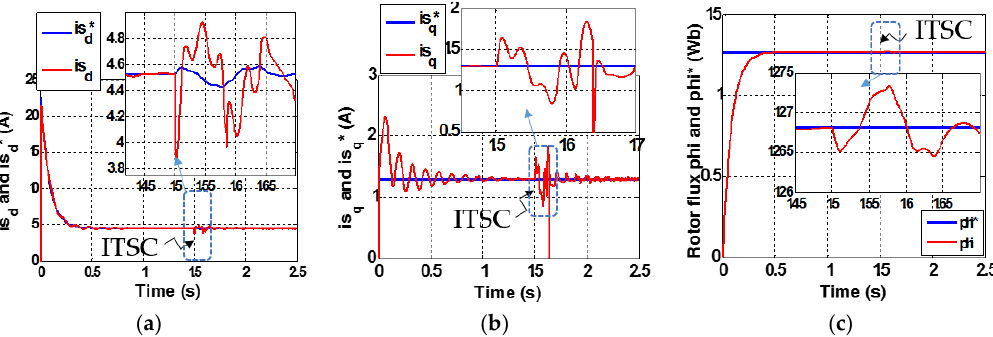
Figure 7. Simulation results of ( a ) current i sd and its reference i sd * ; ( b ) current i sq and its reference i sq * ; and ( c ) estimated rotor flux ϕ r and its reference ϕ r and their zooms at t = 1.5 s of wind turbine IG with ITSC fault of 30% of s 1 -phase.